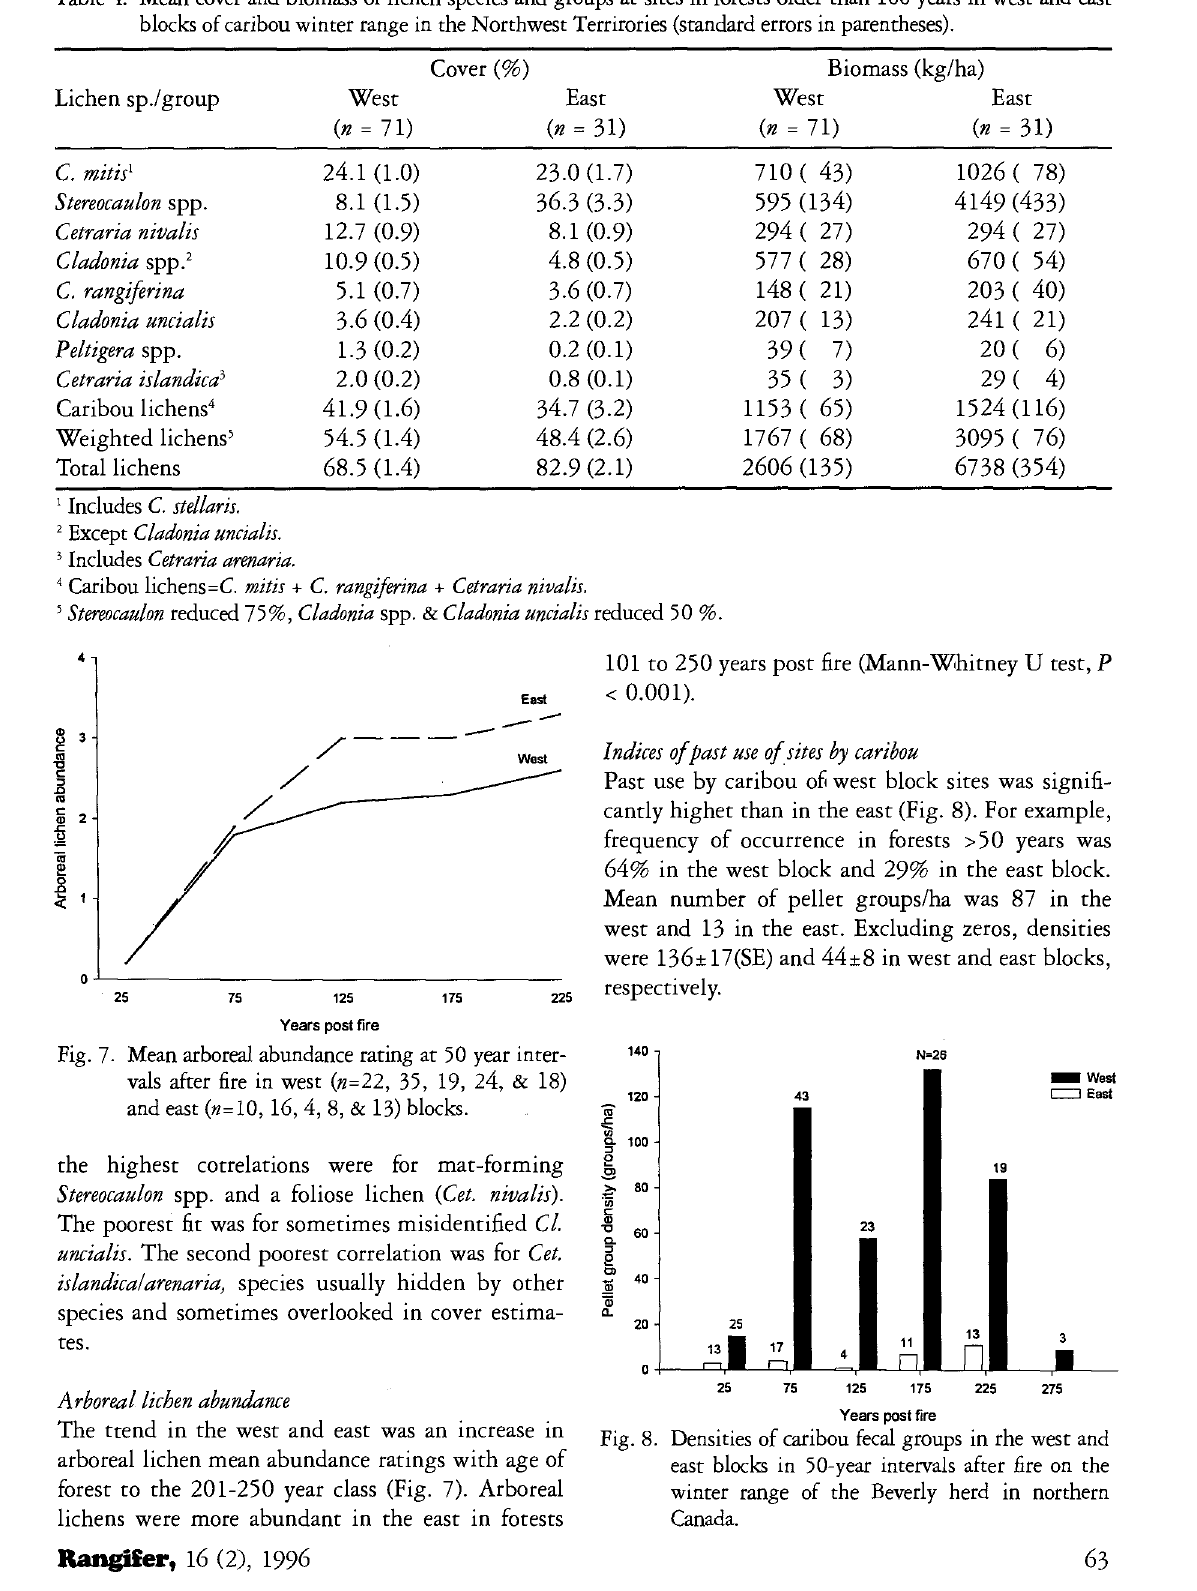
Table 4. Mean cover and biomass of lichen species and groups at sites in forests older than 100 years in west and east blocks of caribou winter range in the Northwest Terrirories (standard errors in parentheses).